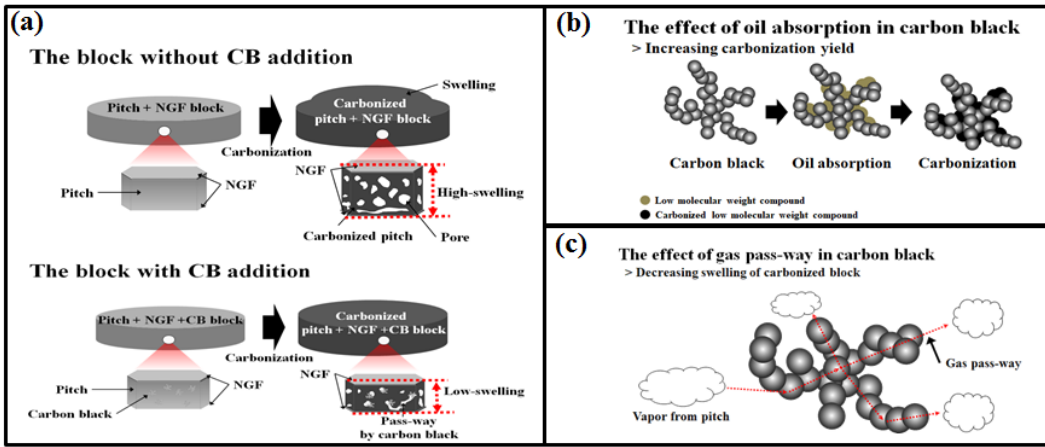
Figure 8. The suggested mechanism for the e ff ect of added CB in carbon block during the carbonization process; ( a ) the change of block shape by CB addition, ( b ) the e ff ect of oil absorption in CB, and ( c ) the e ff ect of gas pass-way in